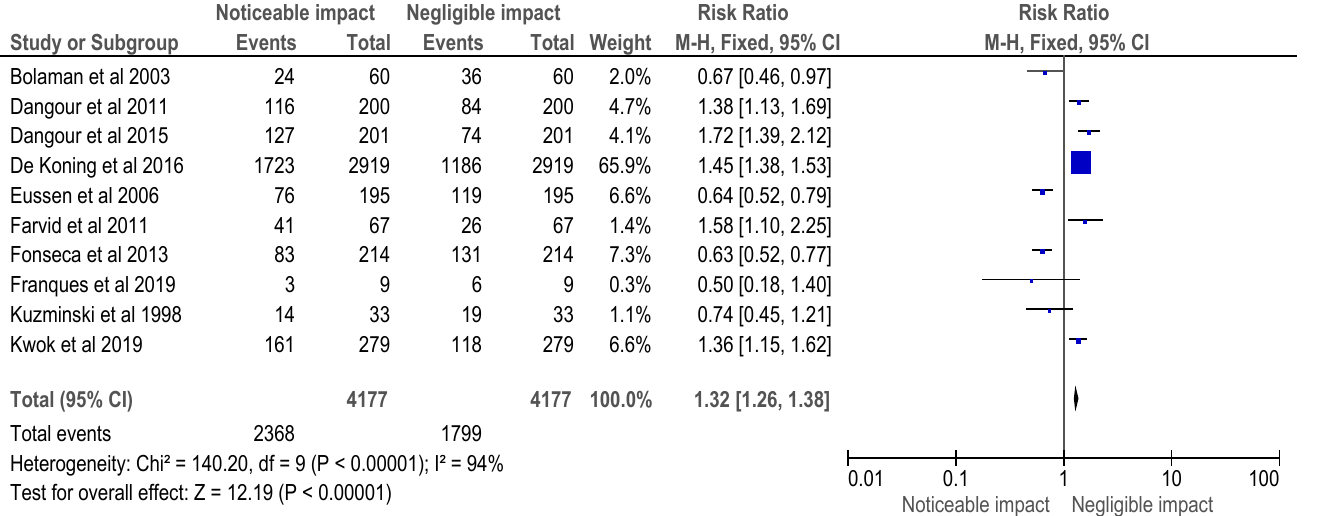
Figure 2. Risk ratio of selected randomised control trials represented on a forest plot after their meta- analysis, in which the noticeable impact of Vitamin B12 interventions compared to their negative to negligible impact was assessed (where the blue dot represents the study with the most weight and the rhombus represents the total weight of the forest plot) [15–22,26,27].